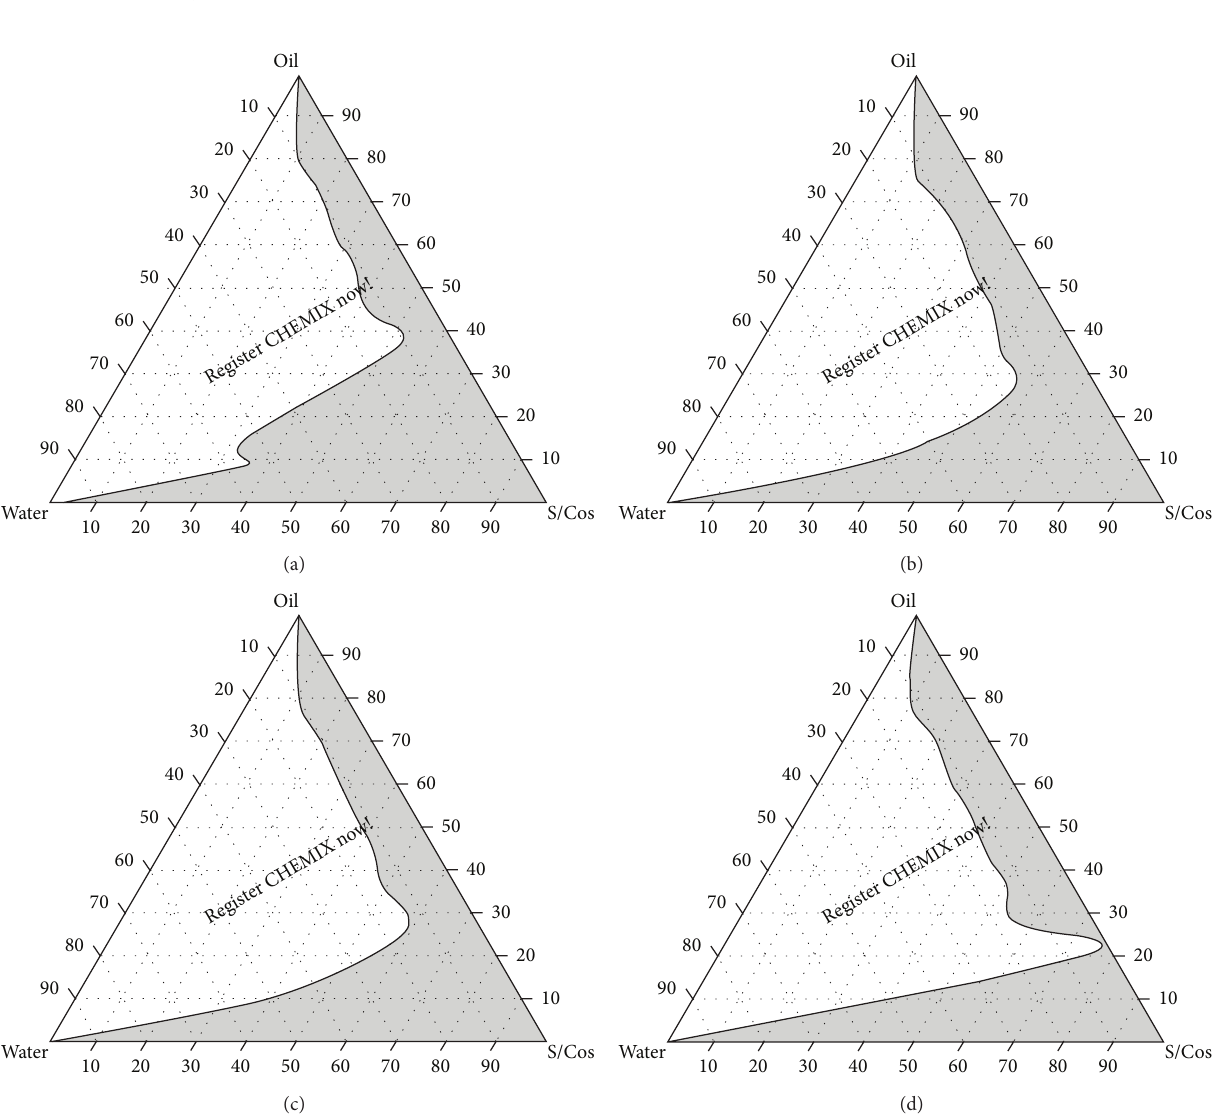
Figure 1: Pseudoternary phase diagrams with the following components: oil = Capmul MCM, surfactant = Tween 80, and cosurfactant = PEG 400. S/Cos ratio of A is 1:1, B is 2 :1, C is 3 : 1, and D is 4: 1. S/Cos indicates surfactant/cosurfactant. Area in grey shade indicates self-emulsifying